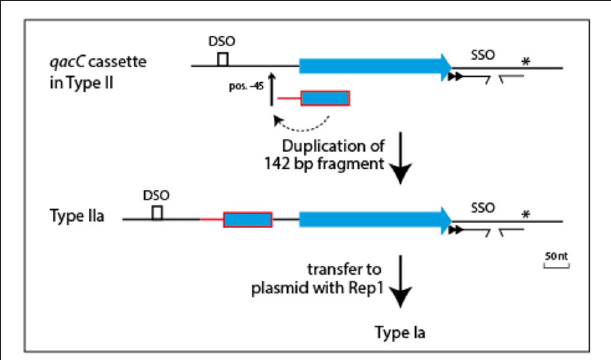
FIGURE 3 | Model for formation of the qacC’ fragment present in Types Ia and IIa plasmids. A single nt insertion 137 nt downstream of qacC (indicated by the asterisk) is present in some Type II plasmids (e.g., pLUH01) and conserved in both Types Ia and IIa. This is evidence that the duplication of the 142 nt-long qacC’ fragment, inserted at position − 45, occurred in a Type II plasmid to form Type IIa, after which the complete locus was mobilized to give Type Ia.